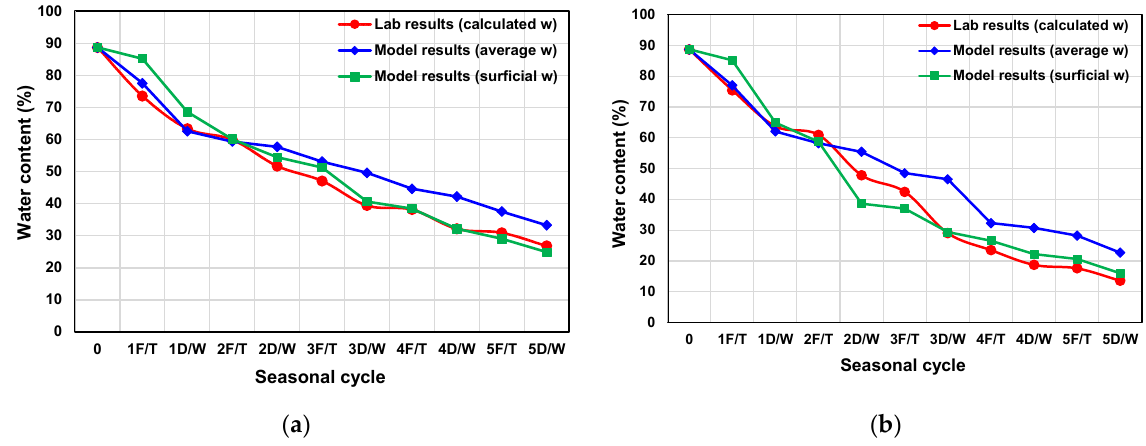
Figure 10. Second-phase testing comparisons: Water content values per seasonal cycle for the centrifuged tailings samples under a temperature gradient of ( a ) 0.083 °C/mm and ( b ) 0.028 °C/mm.